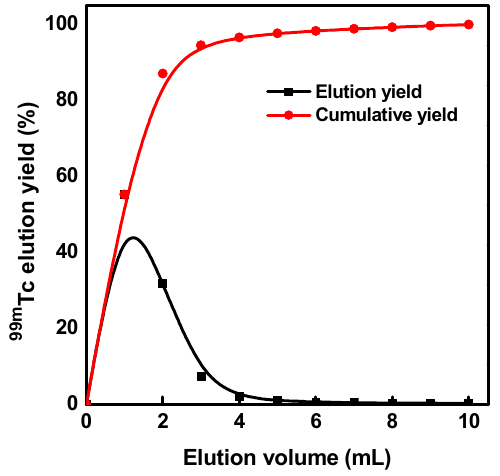
Figure 6. Elution profile of 99m Tc from mesoporous alumina- 99 Mo column. In order to evaluate the effectiveness of the radiochemical separation process, the generated eluates were examined based on their radiochemical, radionuclidic, and chemical purity. To investigate the radiochemical purity, 99m TcO 4 − species were separated using chromatography paper (Whatman No. 1) developed in 85% methanol medium. Figure 7 shows the radio-chromatogram obtained for the 99m Tc eluates. In all chromatograms, the radiochemical (RC) purity was >99%, and only one peak was detected at R f ≈ 0.8 corresponding to 99m TcO 4 − [45,46]. This value agrees with the recommended specifications for the preparation of 99m Tc-labelled compounds [31,47,48].